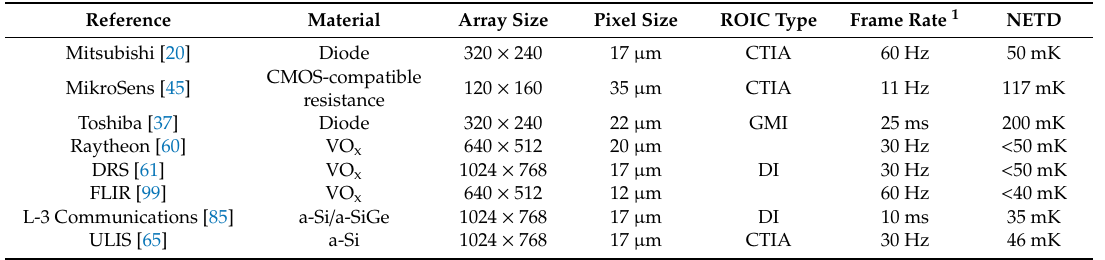
Table 4. CMOS-compatible microbolometer IRFPAs versus other microbolometer IRFPAs.